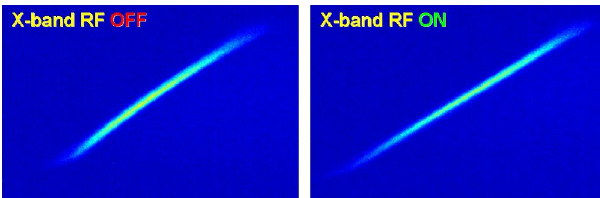
FIG. 35. (Color) The rms bunch length at 135 MeV versus bunch charge. Measured values are compared to simulations using a thermal transverse emittance of 0 : 6 (cid:2) m per millimeter of radius and a 5-ps FWHM laser pulse.